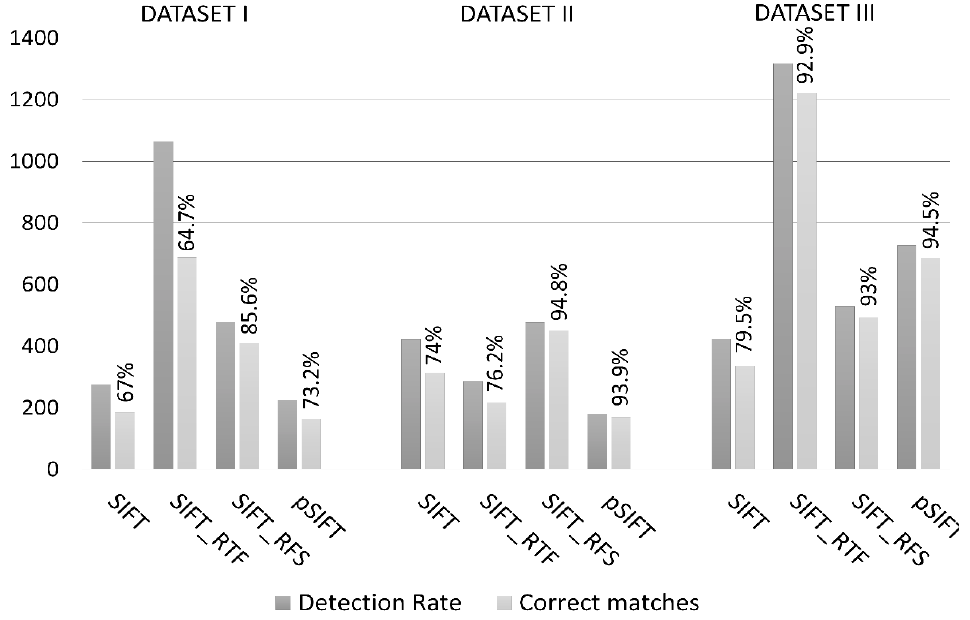
Figure 8. Experiment I: Total of detection rate and location correctness of SIFT, SIFT RTF , pSIFT, and the proposed method SIFT RFS for indoor (data set I), forest (data set II), and urban (data set III) scenes.